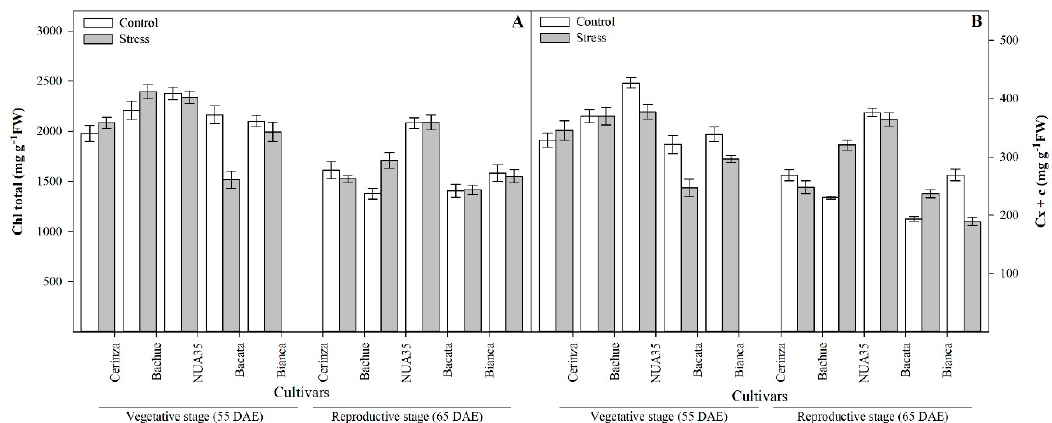
Figure 1. Effect of water deficit stress on two different phenological stages (vegetative (55 Days after Emergence (DAE)) and reproductive (65 DAE)) on total chlorophyll ( A ) and total carotenoids ( B ) in five bush bean cultivars. Bars represent the mean of four plants ± standard error; FW, Fresh weight.